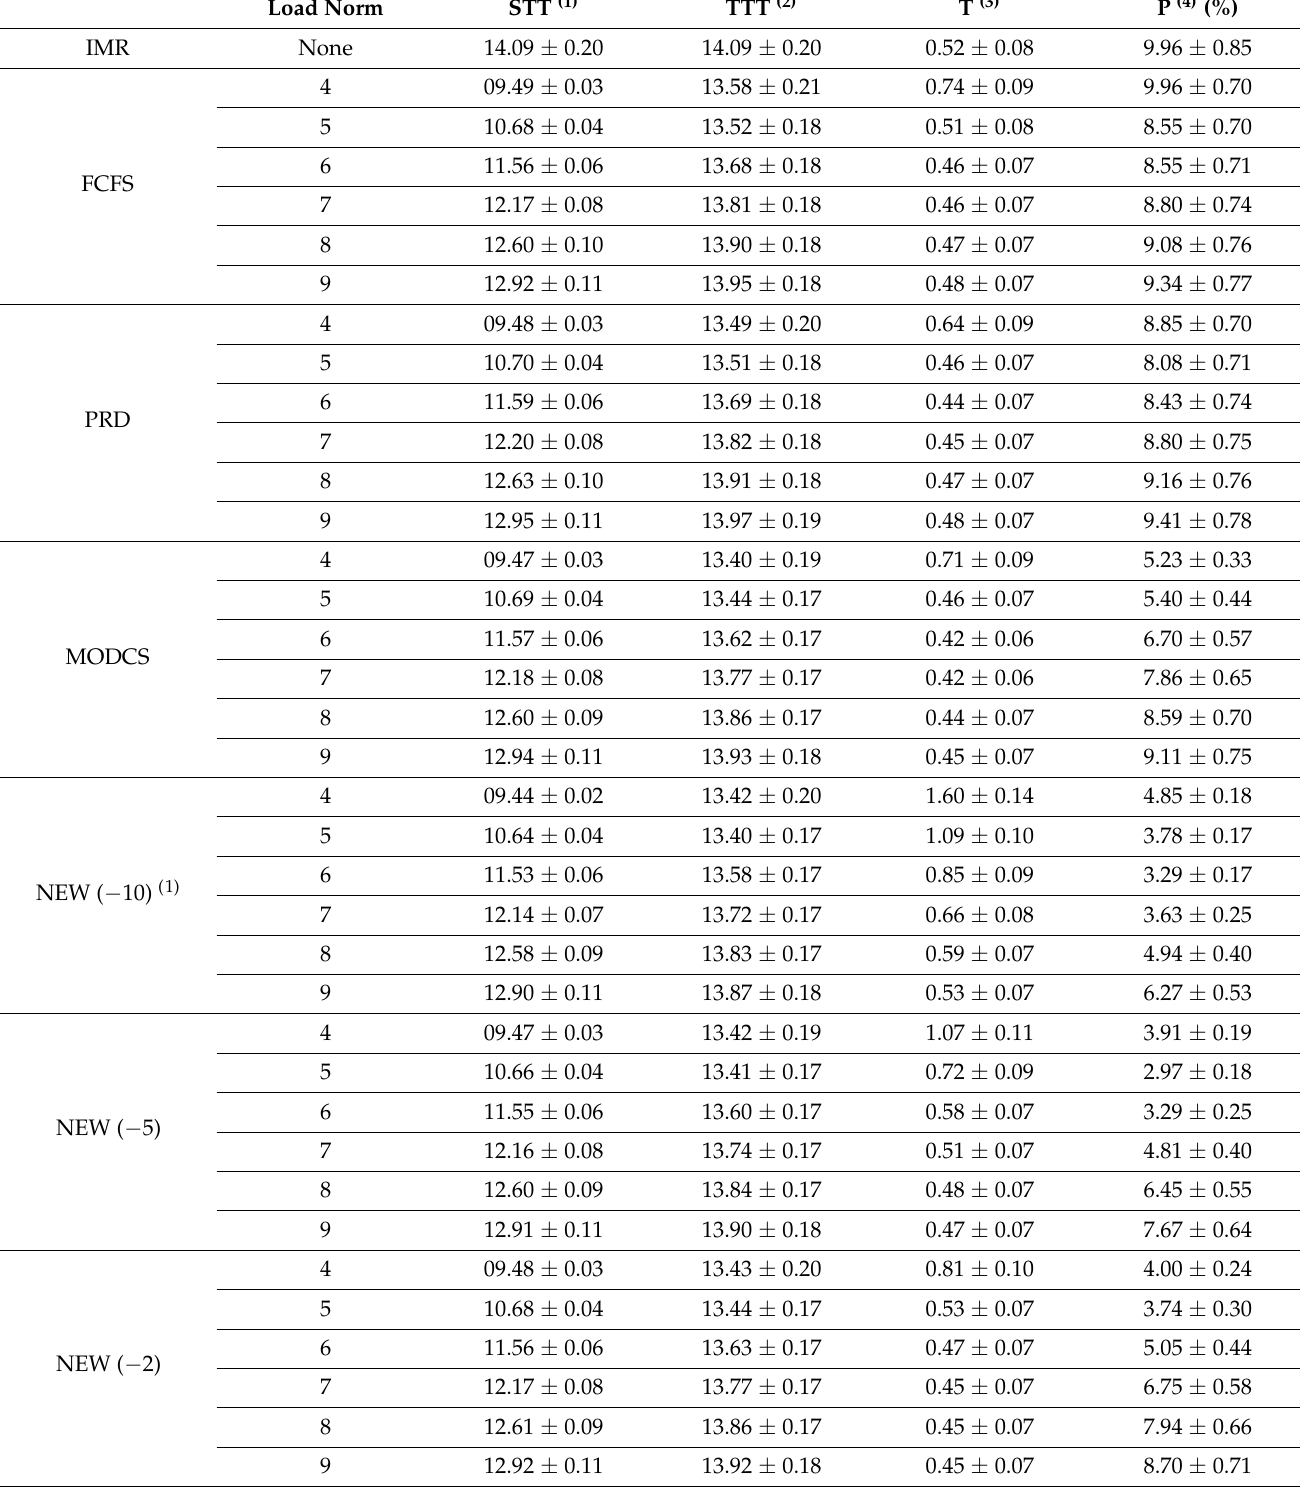
Table 6. Simulation results for CV =